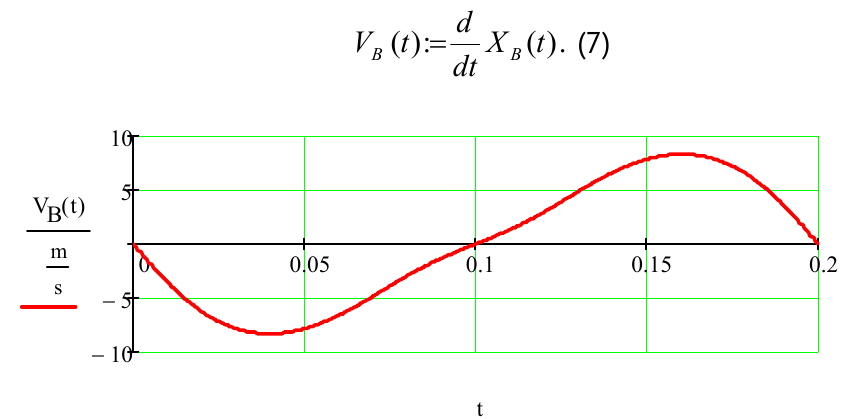
Figure 7. Point B velocity graph obtained in